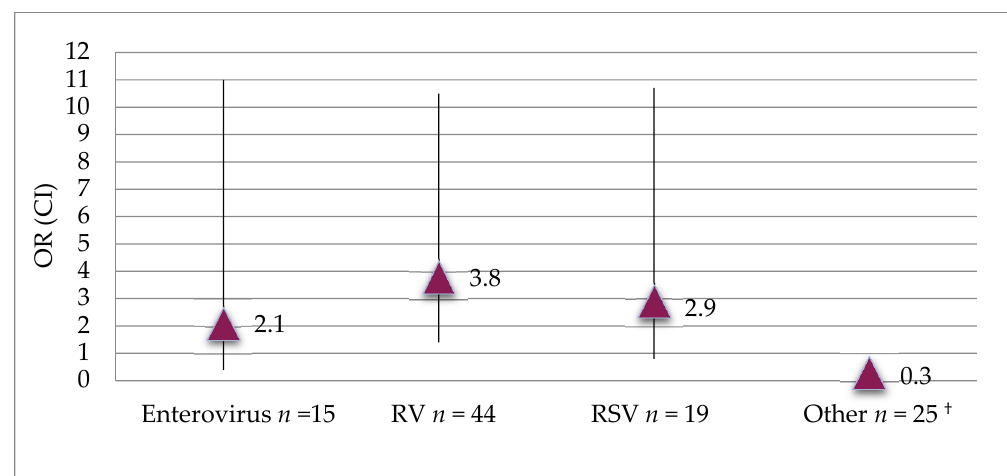
Figure 2. The association between infection with different viruses at inclusion and asthma at age 7 years. † Adenovirus, bocavirus, coronavirus (229E, HKU1, NL63, OC43), influenza (A, H1N1, B), metapneumovirus, and parainfluenzavirus (1, 2, 3).